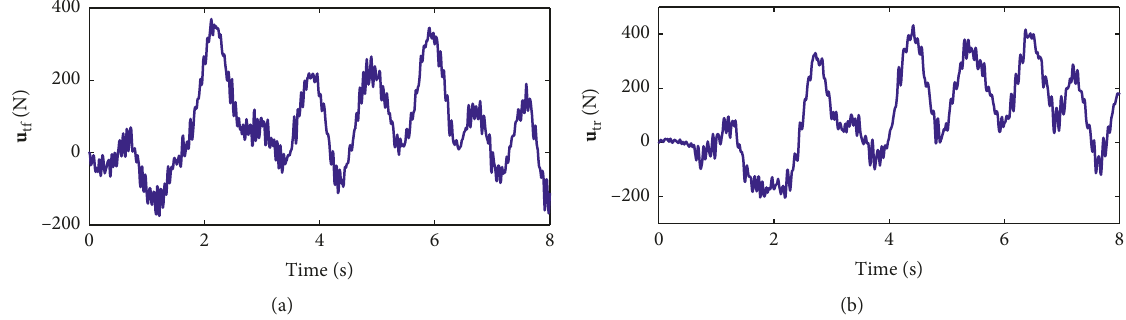
Figure 5: The control forces of (a) the front actuator and (b) rear actuator under the random road